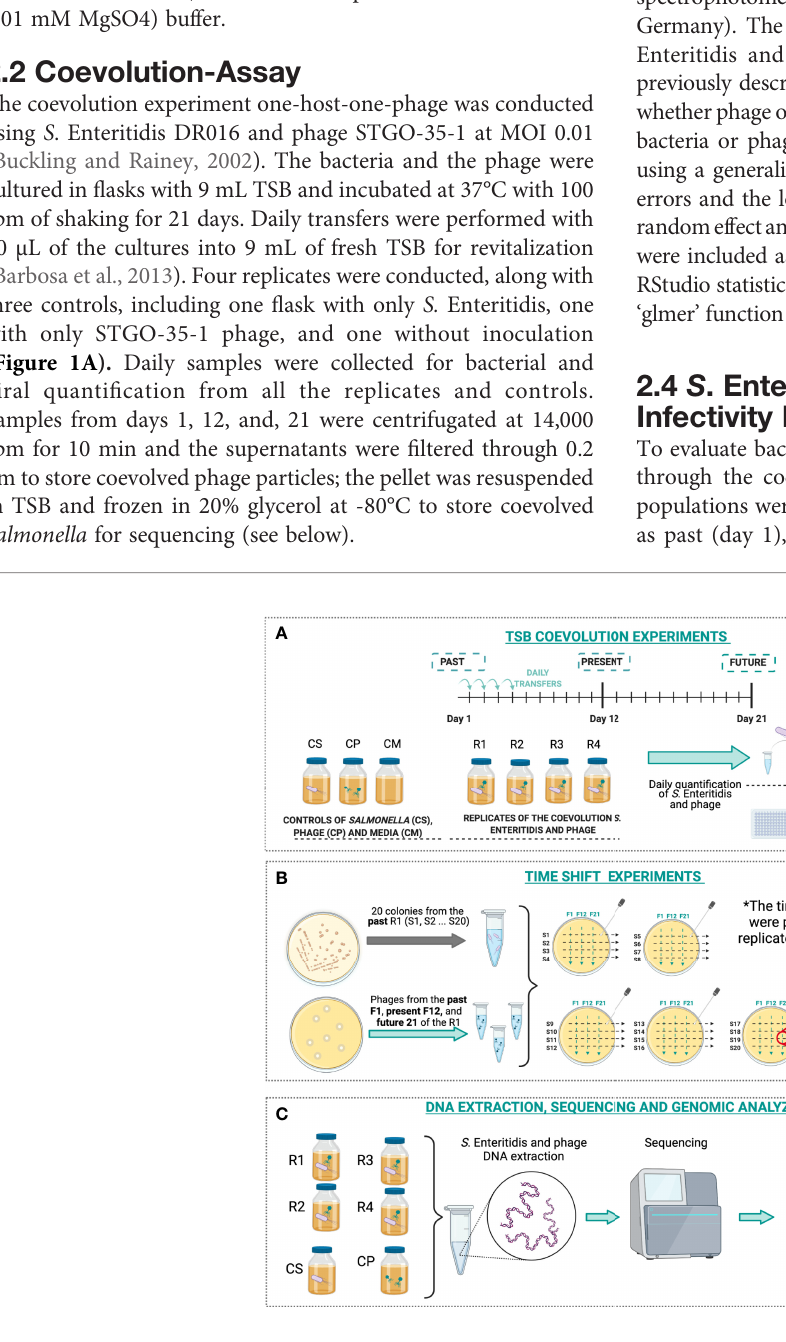
FIGURE 1 | Schematic illustration of the experimental design. (A) Experimental design for the coevolution dynamics. Four replicates were placed (R1, R2, R3, and R4) for the infection of S . Enteritidis with the phage. Daily transfers were performed to fresh media, and samples were analyzed for viral and bacterial quanti fi cation. (B) Time shift experiment for past, present, and future phage and bacterial populations, for this, 20 colonies were selected for S . Enteritidis in all the three times for the four replicates and were tested against phages from the past, present, and future. * indicates the replicates in which the time shifts were performed. (C) The extraction of the DNA of S . Enteritidis was conducted for S . Enteritidis of days 1 and 21 for all replicates and for phage from R1 at days 1 and 21. The SNP analyzes were performed with Freebayes using the CS as the original S .